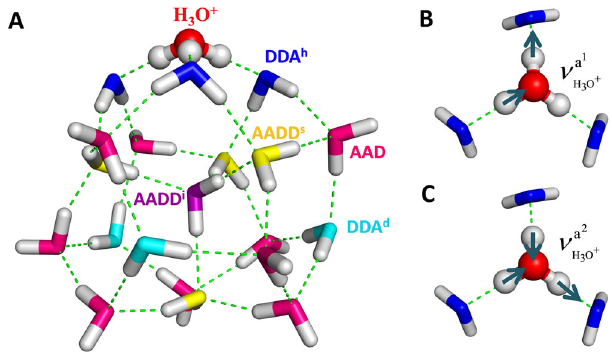
Fig. 1 Representation of the H + (H 2 O) 21 cluster. A The optimized Eigen- state H + (H 2 O) 21 structure using the fragment-based CCD/aug-cc-pVDZ level of theory. H 3 O + is at the top of the structure. There are two types of DDA water molecules: three are hydrogen-bonded with H 3 O + (blue, DDA h ) and three are distant from H 3 O + (turquoise, DDA d ). Nine AAD-type water molecules are colored in pink. Four-coordinated AADD water molecules are colored in purple and yellow, respectively, corresponding to the one in the interior (AADD i ) and four at the surface (AADD s ). B , C represent two asymmetric O-H stretching modes of H 3 O + , denoted ν a 1